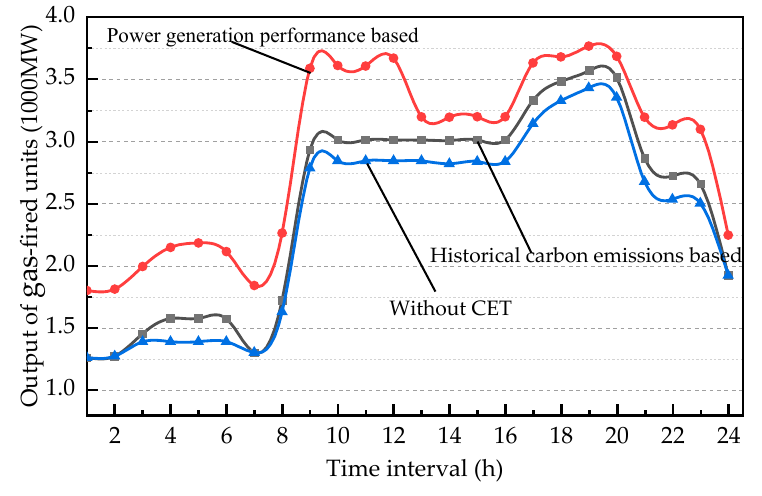
Figure 13. Comparison of outputs of gas-fired units.